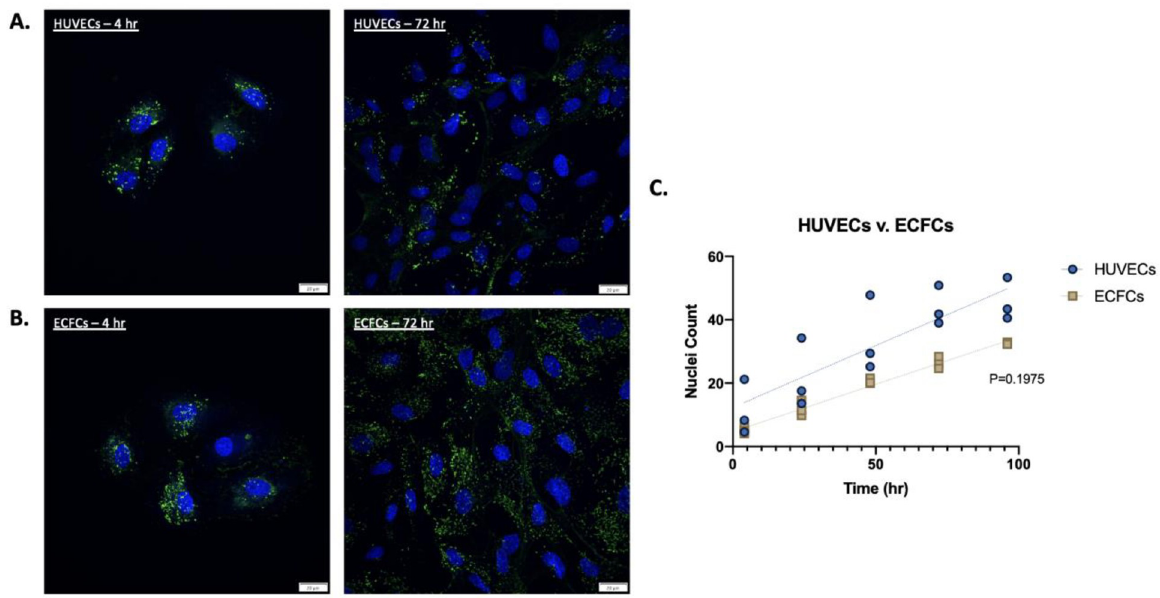
Fig 1. Morphology and growth rates of HUVECs and ECFCs. (A) A sample of HUVECs seeded on gelatin coverslips. After 72 hrs. of culture with a seeding density of 30,000 cells/cm 2 , cells were fixed and stained with ProLong Mountant with DAPI and anti-VWF FITC antibody to visualize nuclei and VWF, respectively. (B) The same was done for ECFCs, showing WPB distribution. (C) Nuclei count of HUVECs and ECFCs were evaluated at varying incubation time points (4, 24, 48, 72, 96 hrs.) with a constant seeding density of 30,000 cells/cm 2 (n = 3). The dotted lines represent the growth rate curves as analyzed by a linear regression line of each cell line. The growth rate slopes for HUVECs and ECFCs are 0.39 and 0.30, respectively. The slopes are not significantly different, and P-value shown was determined by linear regression (GraphPad Prism).